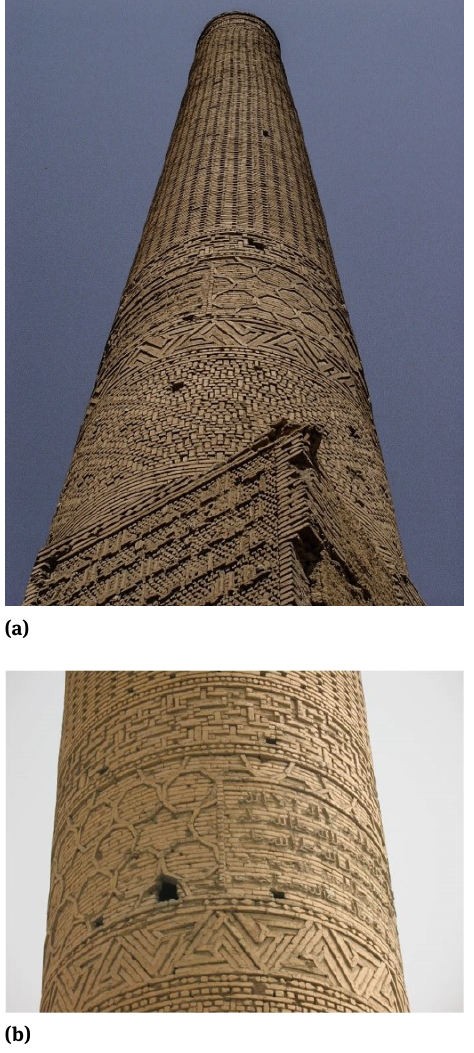
Figure 8: The brickwork ornamentations on Chehel-Dokhtaran Minaret a) overall view; b) detailed view.